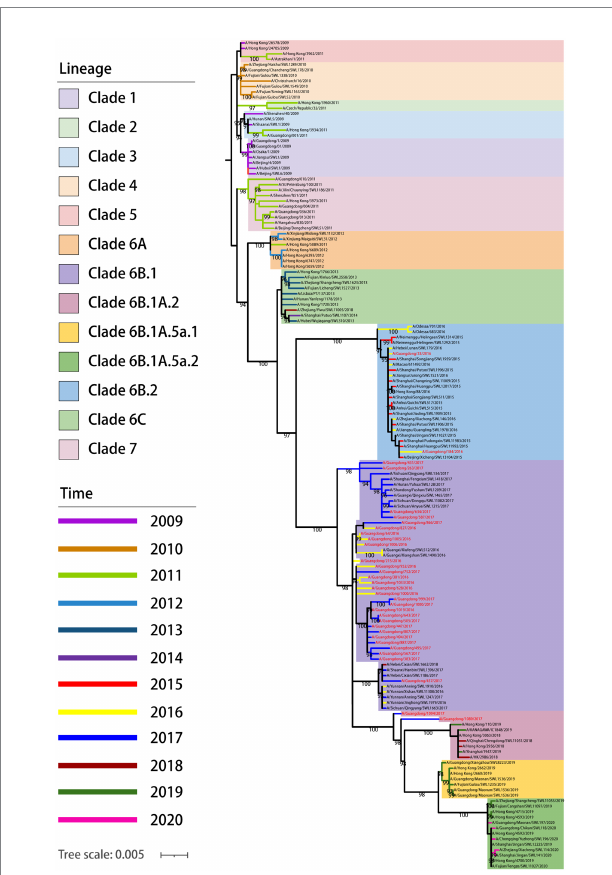
FIGURE 2 Phylogenetic relationship of HA gene of pdm/09 viruses in China from 2009 to 2020. Different clades and years are denoted by different markers. All branch lengths are scaled according to the numbers of substitutions per site (subs/site). Phylogenetic tree was estimated using genetic distances calculated by maximum likelihood under the GTR + F + G4 model. Pdm09 viruses isolated in this study are marked in red; sequences of viruses with names in black were downloaded from